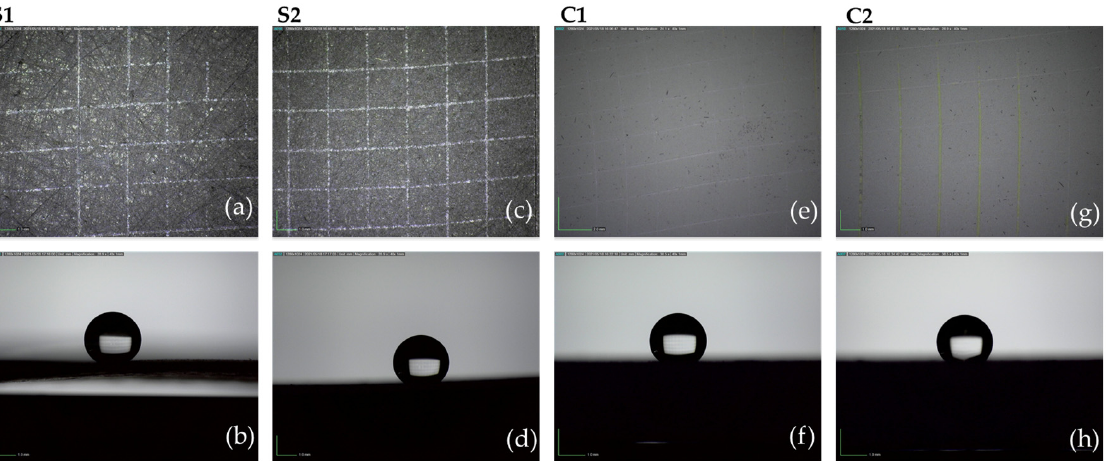
Figure 9. Cutting and tape test carried out on S1 ( a , b ), S2 ( c , d ), C1 ( e , f ), and C2 ( g , h ) samples. On the top are the images of surfaces after the test; on the bottom, water droplets on tested surfaces to measure the residual wettability.